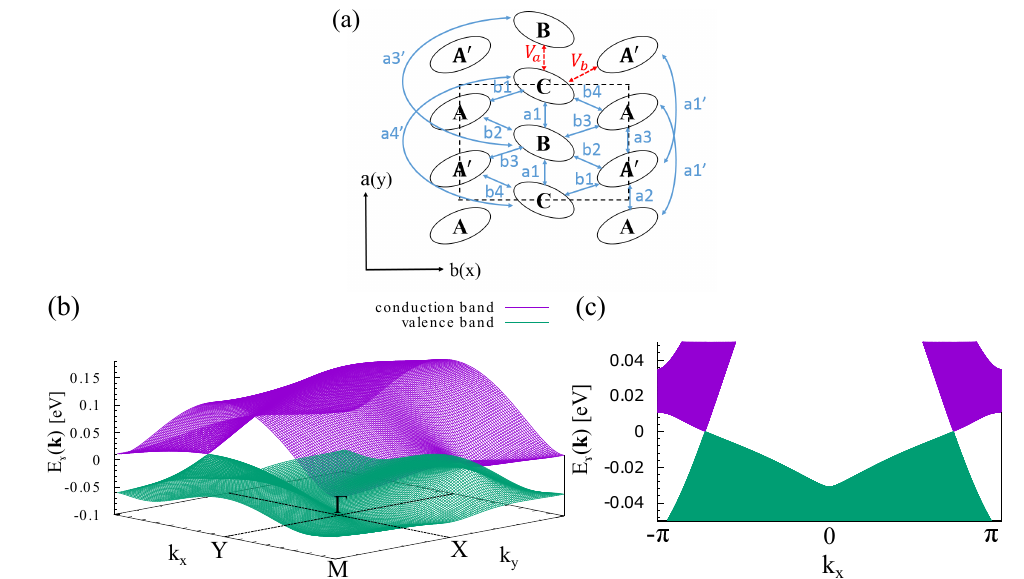
Figure 1. ( a ) Schematic figure of two-dimensional conductive plane in α -(BEDT-TTF) 2 I 3 . Some ellipses represent sublattices of the BEDT-TTF molecule. In the figure, signs of b1, b2, ..., a4 (cid:48) correspond to transfer integrals t b 1 , t b 2 ,..., t (cid:48) between two molecules. Nearest-neighbor Coulomb repulsions V a , a 4 V b are represented by the red dotted arrows. On-site Coulomb repulsion U also exists, although it is not shown in the figure. The unit cell is a region surrounded by a black dotted square in the figure. In the absence of the Coulomb interactions, the inversion symmetry points exist on B and C sublattices, and at the midpoint between A and A (cid:48) sublattices. ( b ) The conduction band (purple) and valence band (green) in the massless DE phase for V a = 0.18, and ( c ) a view of same two bands projected from the side along k x axis.